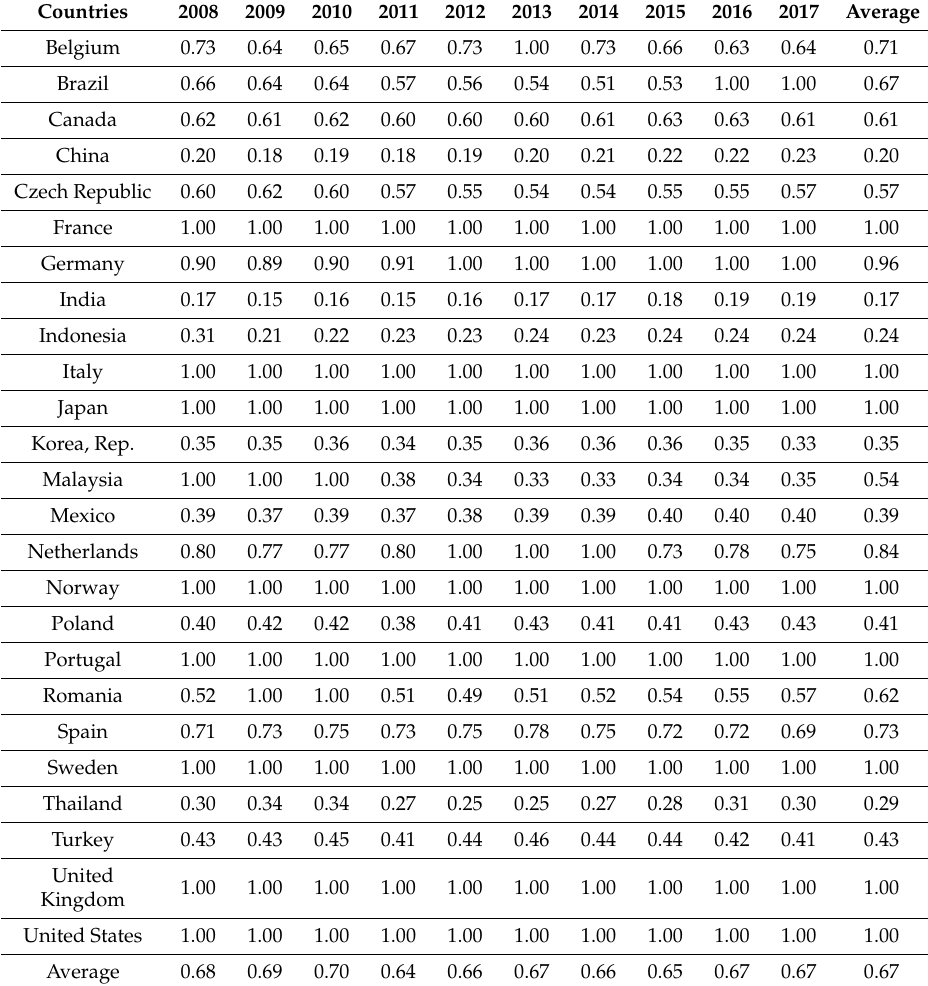
Table 1. Energy e ffi ciency score during